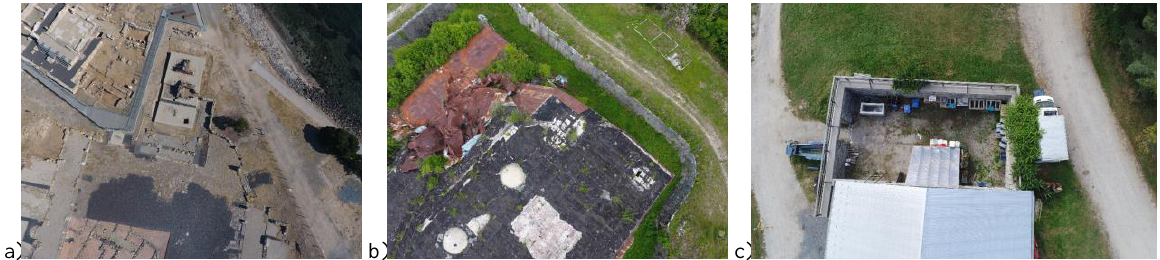
Figure 4. Images from a DJI Phantom 4 from each of the test cases: Nora (a), Forte Mattarello (b), Moore Farm (c) Then, a ground plane is created using the altitude of the UAV